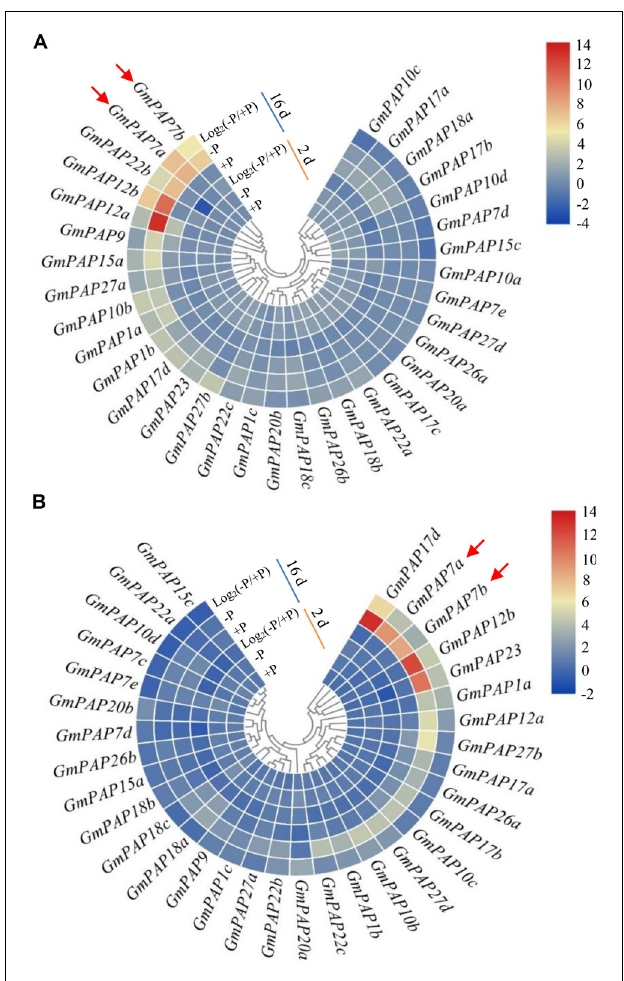
FIGURE 4 | Heatmap analysis of the expression patterns of GmPAP members in leaves and roots in response to P deficiency. (A) Leaves. (B) Roots. Soybean seedlings were grown in nutrient solution supplemented with 5 µ M (–P) or 250 µ M (+P) KH 2 PO 4 . The leaves and roots were harvested for qRT-PCR analysis after 2 and 16 days of P treatment. Log 2 (–P/+P) represents the binary logarithm of the fold changes of the relative expression of GmPAP members under Pi-deficient and Pi-sufficient conditions. The data are the means of four replicates. GmPAP7a and GmPAP7b are indicated by red arrows.